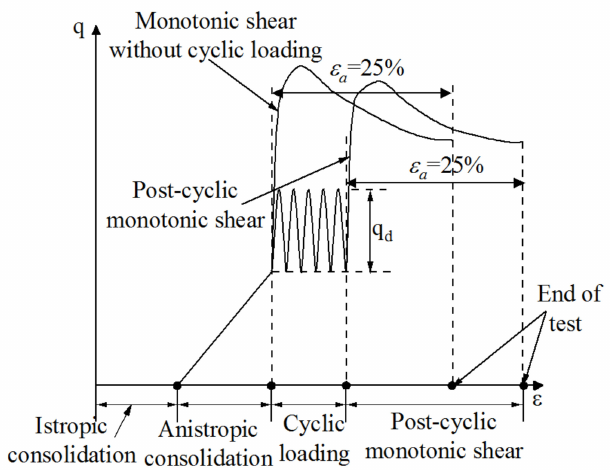
Figure 2. Loading protocol adopted in this study.